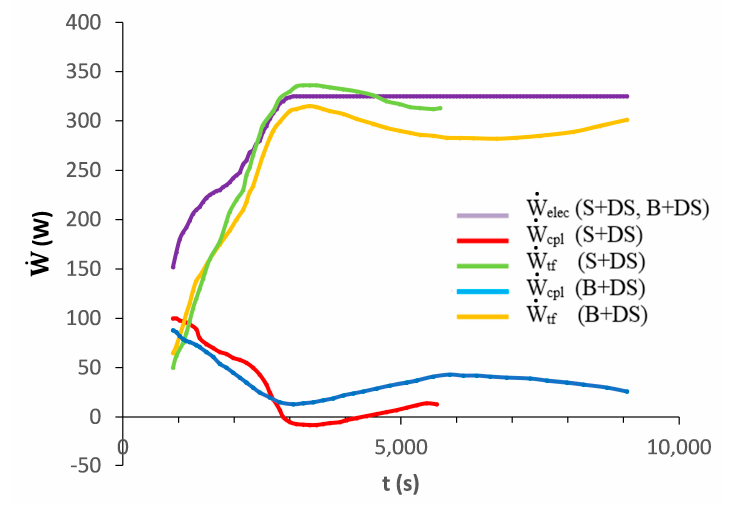
Figure 7. Time history of the power transfer.